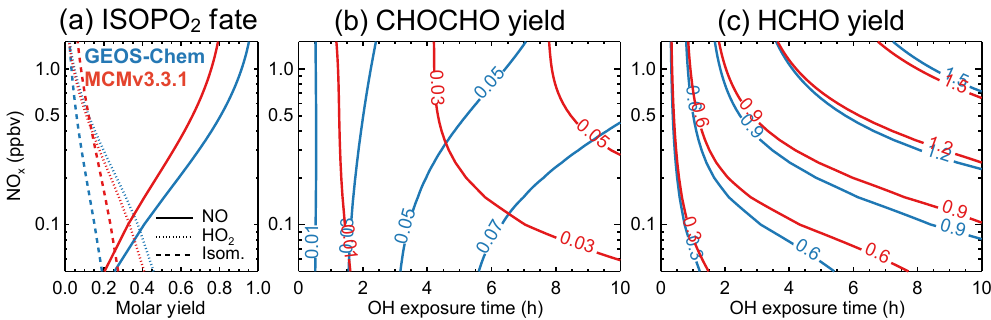
Figure 2. Cumulative time- and NO x -dependent molar yields of CHOCHO and HCHO from isoprene oxidation in the GEOS-Chem and MCM3.3.1 chemical mechanisms. Results are from box model simulations with fixed NO x concentrations as described in the text, and are presented as functions of the imposed NO x concentration (vertical axis). Panel (a) shows the isoprene peroxy radical (ISOPO 2 ) branching ratios for reaction with NO, HO 2 , and isomerization. Panels (b, c) show the time-dependent cumulative yields of CHOCHO and HCHO, where time is normalized by OH exposure (Eq. 1). “OH exposure time” is equivalent to time for a constant [OH] = 4 × 10 6 moleculescm − 3